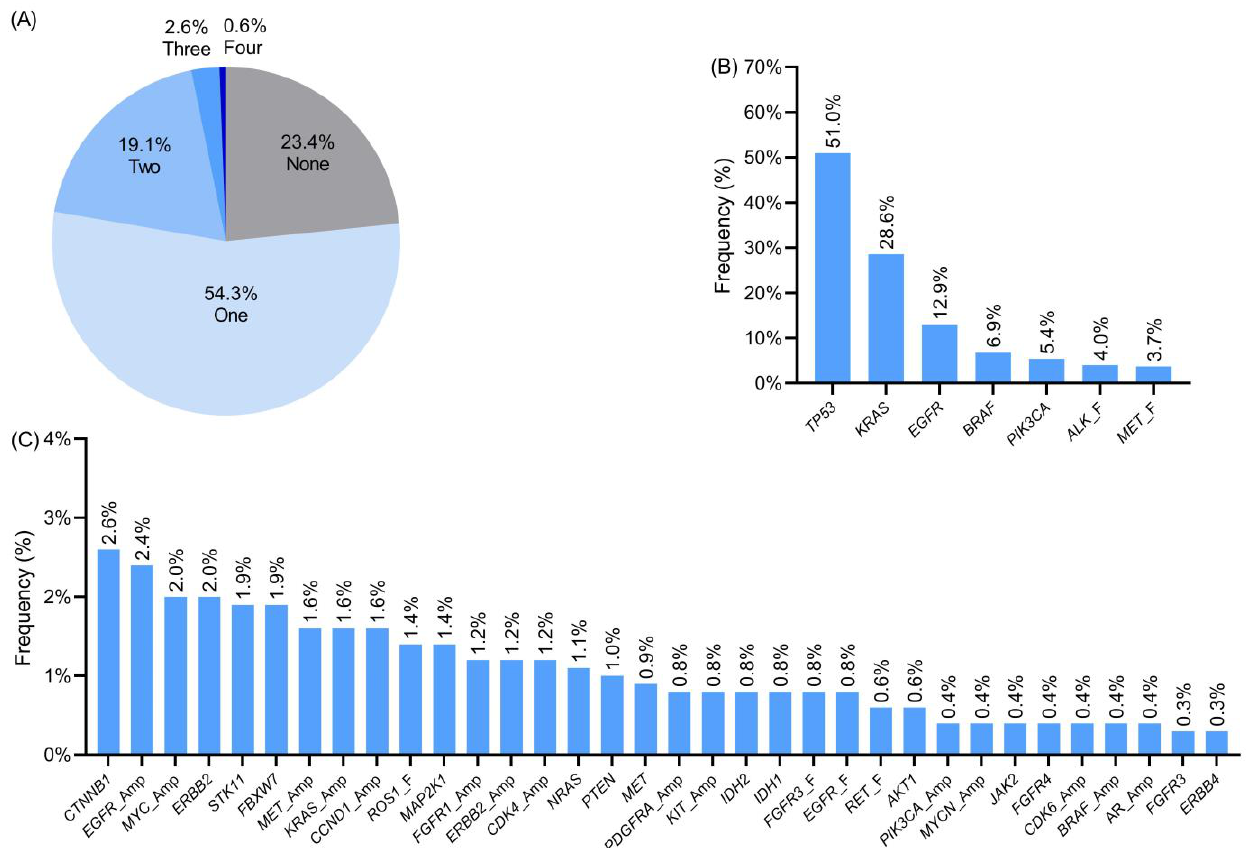
Figure 1. Molecular alterations detected in NGS studies. ( A ) Patient distribution according to the number of genetic alterations detected. ( B , C ) Percentage of samples with molecular alterations in the genes included in the study. Variants detected at frequencies of >3% ( A ) and <3% ( B ). Amp: amplification. F: fusion.